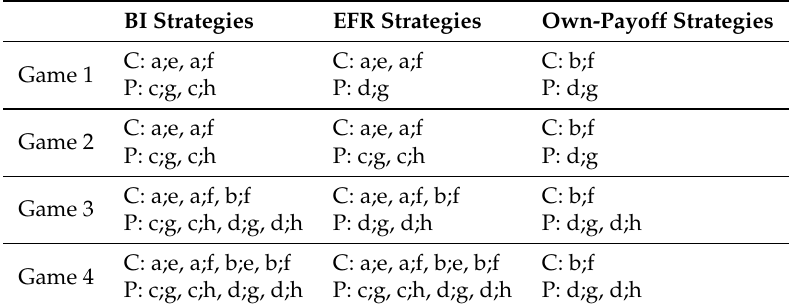
Table 1. BI, EFR and own-payoff strategies for both players in Games 1–4. For example, P’s EFR strategy d; g in Game 1 stands for: “if the game were to get to P’s first decision point, go right (d); if it were to get to P’s second decision point, go down